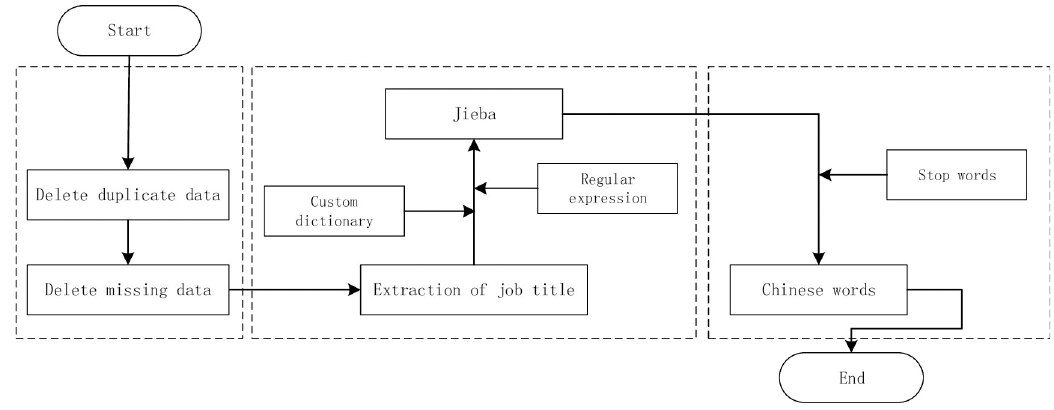
Fig 1. Data preprocessing flow